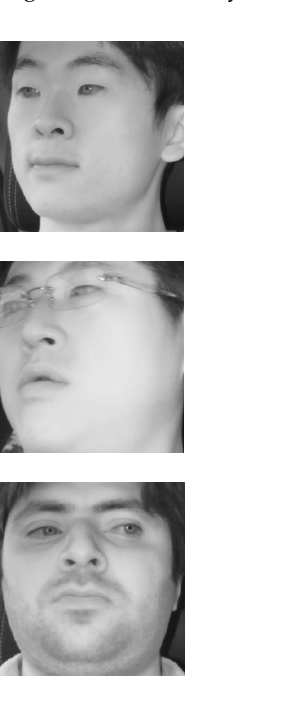
Figure 13. Correctly detected gaze zones with our system. Left, middle, and right figures respectively show the cases that the driver looks at gaze zones of ( a ) 1, 6, and 14; ( b ) 15, 2, and 7; ( c ) 3, 8, and 16.